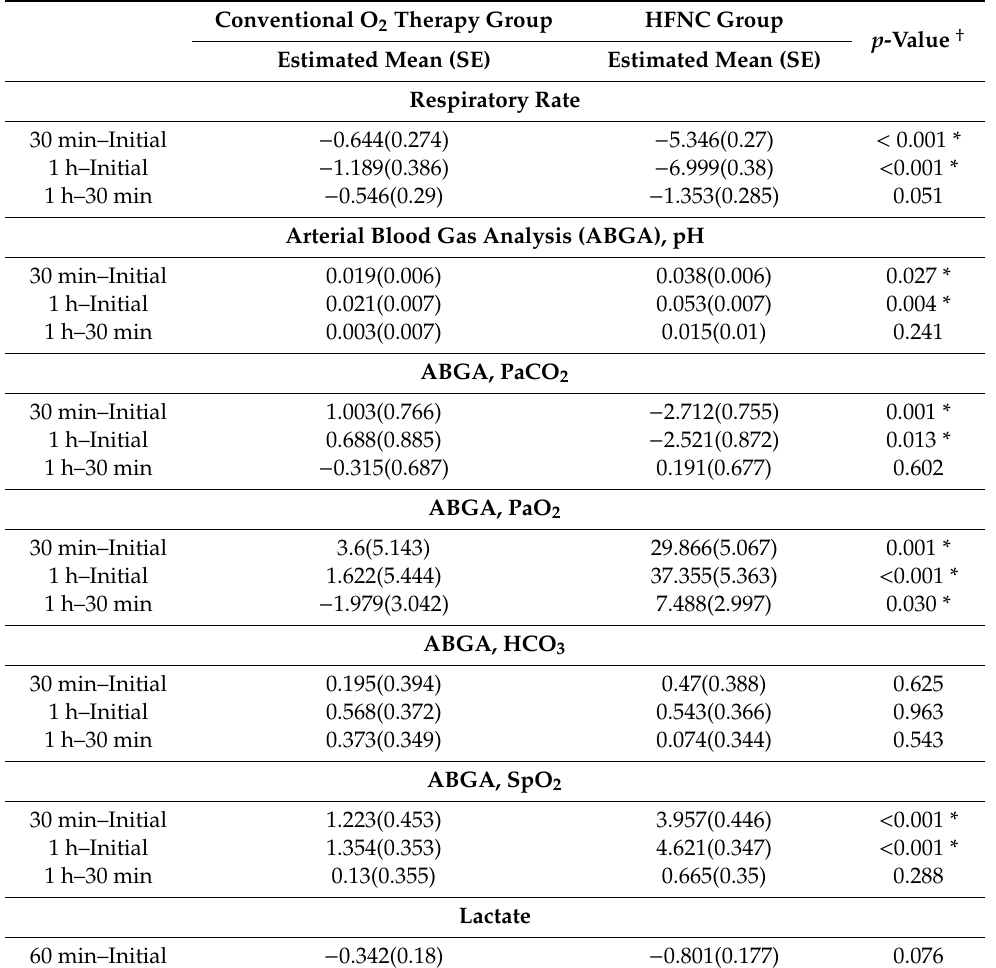
Table 4. Analysis of the interaction between the treatment group and the time-adjusted values for the